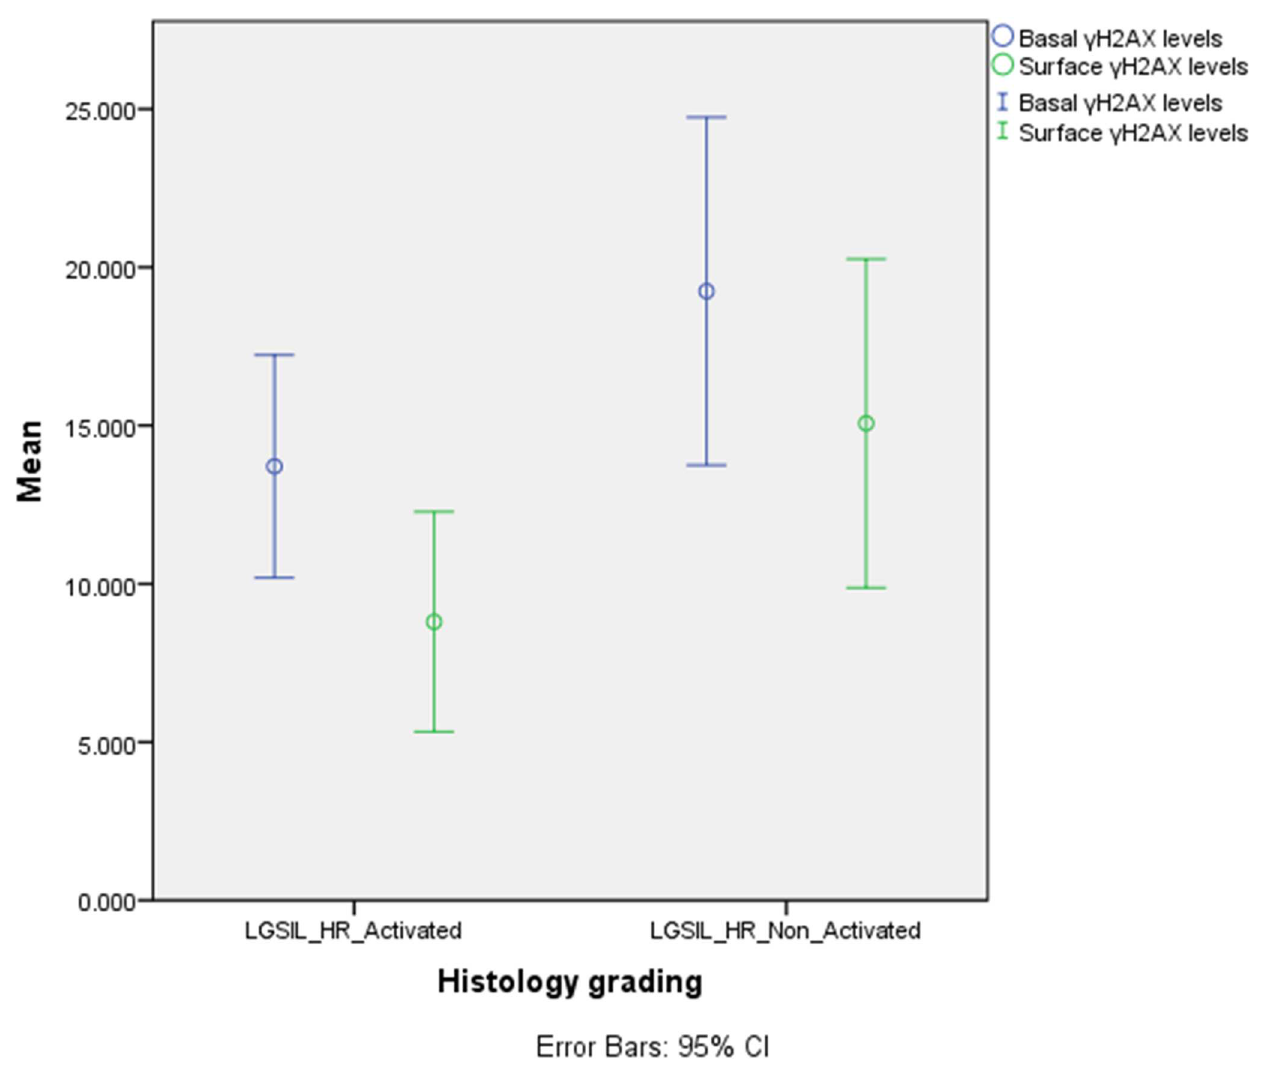
Fig 2. Mean value and 95% confidence intervals, of γ H2AXexpressionfor the basal and surfacecomponents for histological LGSIL cases with HR HPV infection, activated (N = 51) and non-activated cases (N =